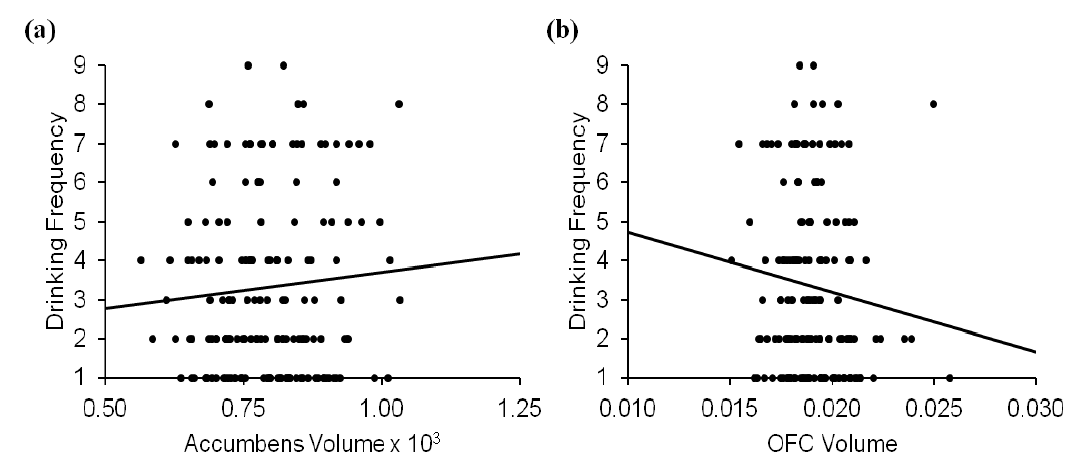
Figure 1. Relationships between ( a ) accumbens volume and past 3-month drinking frequency and ( b ) OFC volume and past 3-month drinking frequency. Volumes are reported as region to intracranial volume ratios.